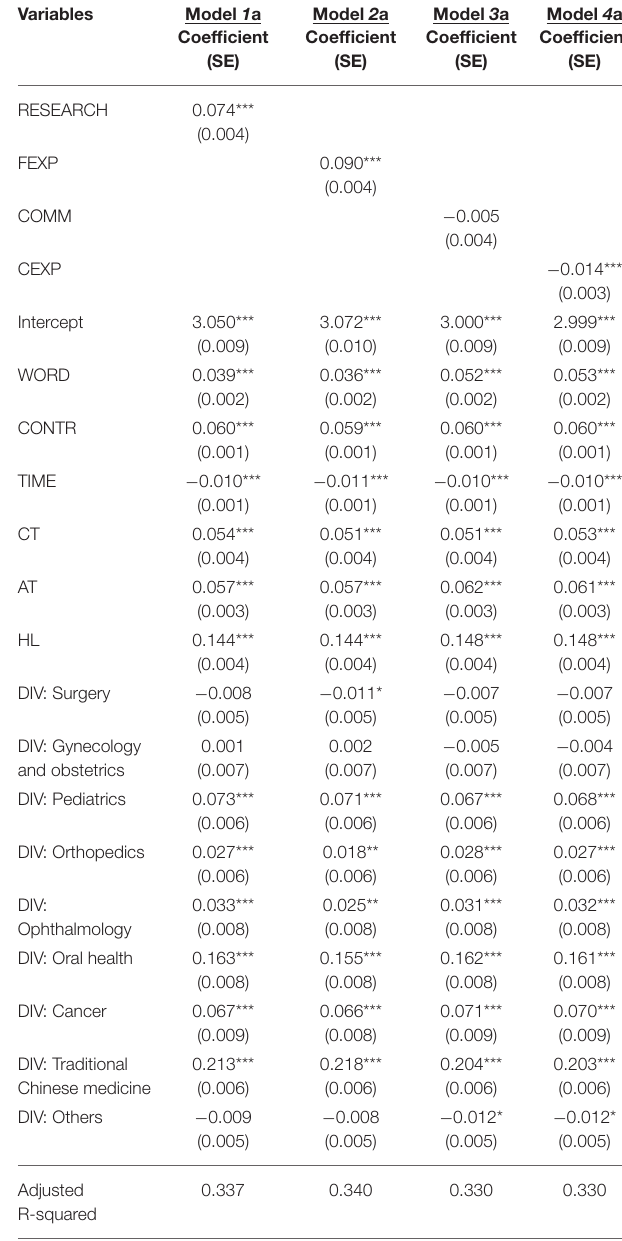
TABLE 3 | Results of the basic regression model. TABLE 4 | Results for the topic model applied to